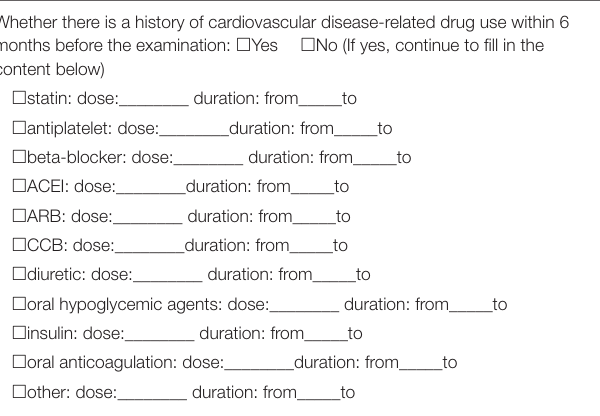
TABLE 4 | Baseline surgical information.